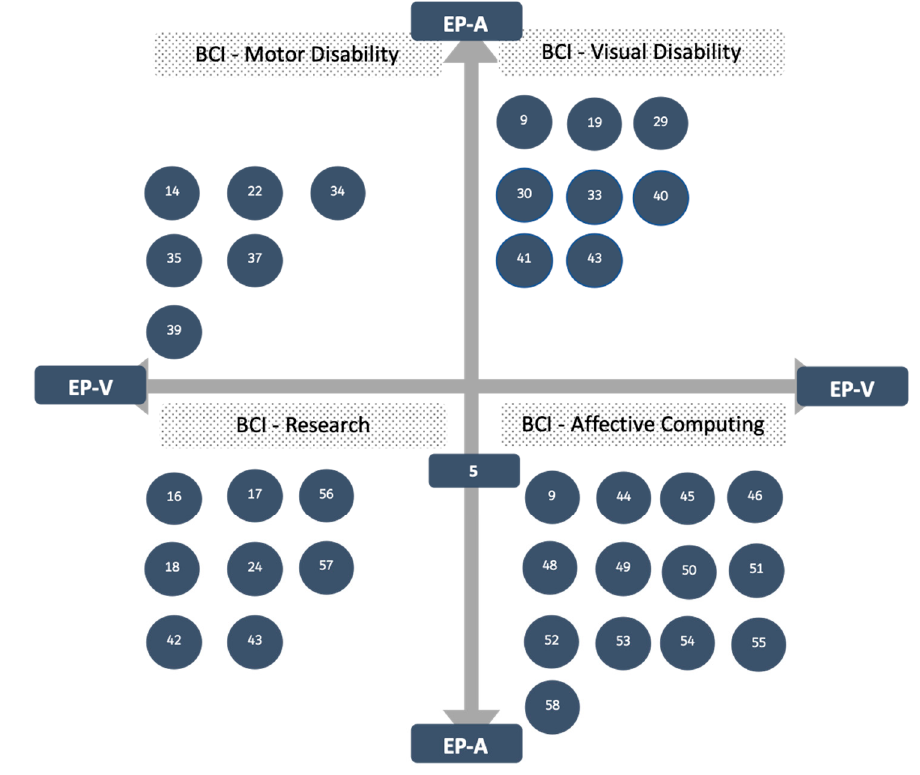
Figure 2. Trends in BCI and AC for people with disabilities.